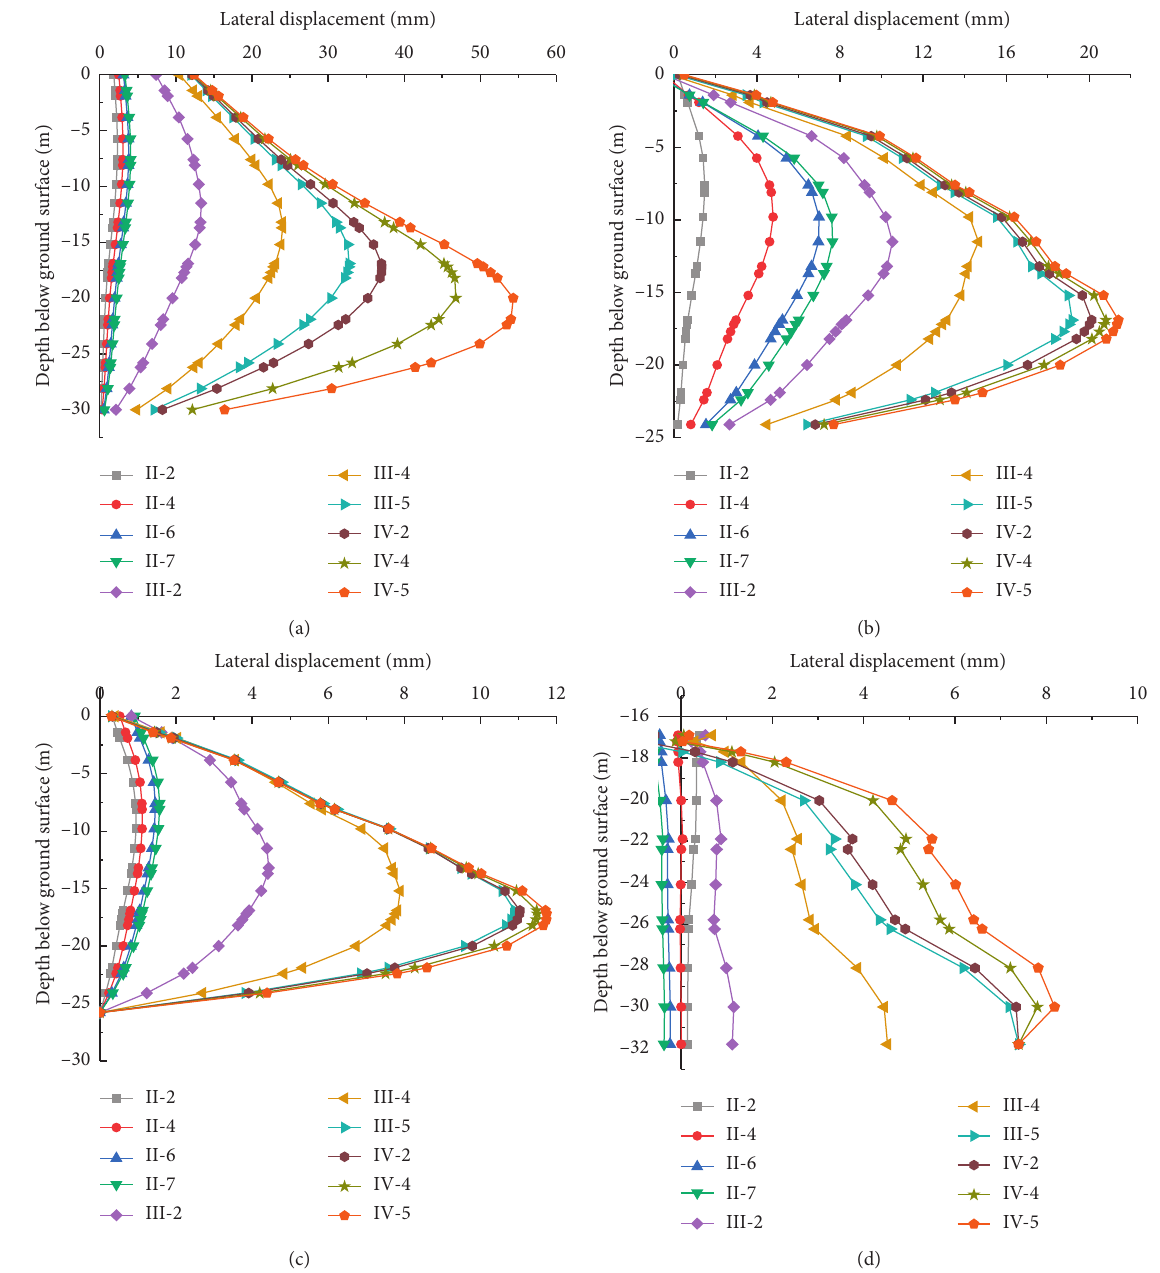
Figure 13: Numerical results of lateral wall displacements at H11 (a), H12 (b), H35 (c), and H36